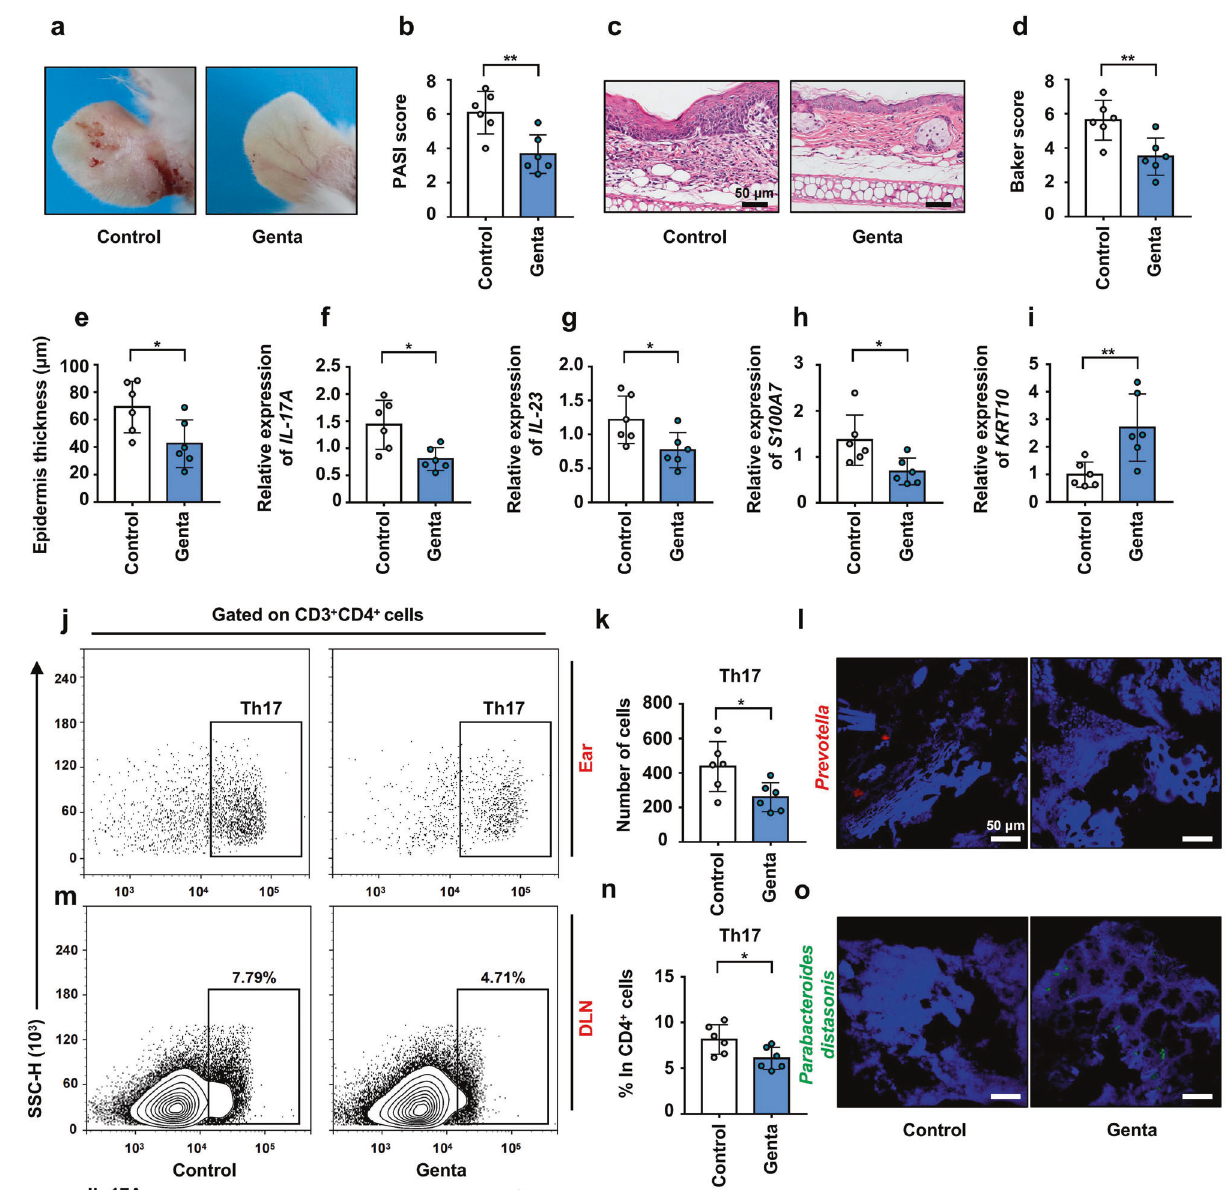
and Genta group mice. c Representative H&E staining of ears (Scale bars: 50 μ m). d Pathological score of ear sections using the Baker scoring system. e Average epidermal thickness. f – i Relative mRNA expression of IL-17A , IL-23 , S100A7 , and KRT10 in the ears of Control and Genta group mice. j Analysis of Th17 cells (CD4 + IL-17 + ) by fl ow cytometry in ears. k Number of Th17 cells in ears. l Representative fl uorescence in situ hybridization for Prevotella (Prv392) in colonic contents. m Analysis of Th17 cells (CD4 + IL-17 + ) by fl ow cytometry in DLNs. n Percentage of Th17 cells in CD4 + cells. o Representative fl uorescence in situ hybridization for Parabacteroides distasonis (PD) in colonic contents. Data presented as mean ± SD on relevant graphs. * P ≤ 0.05; ** P ≤ 0.01; *** P ≤ 0.005 (Two-tailed Student ’ s t -test). ( n =